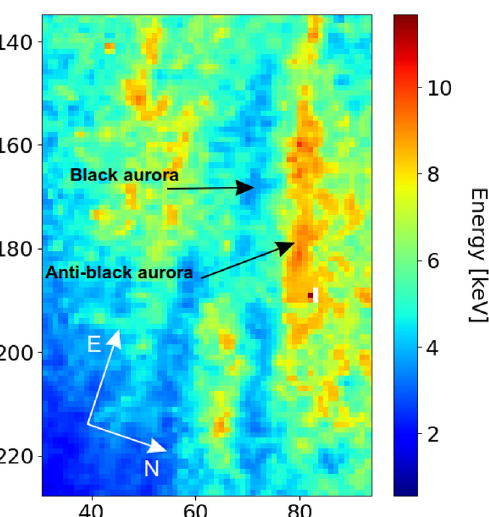
Figure 5. The mean energy of the precipitating electrons for 22:56:19–22:56:28 UT (panels t3–t5 of Figs. 2, 3), determined from the 427.8 and 844.6 nm optical data. The axes represent pixel